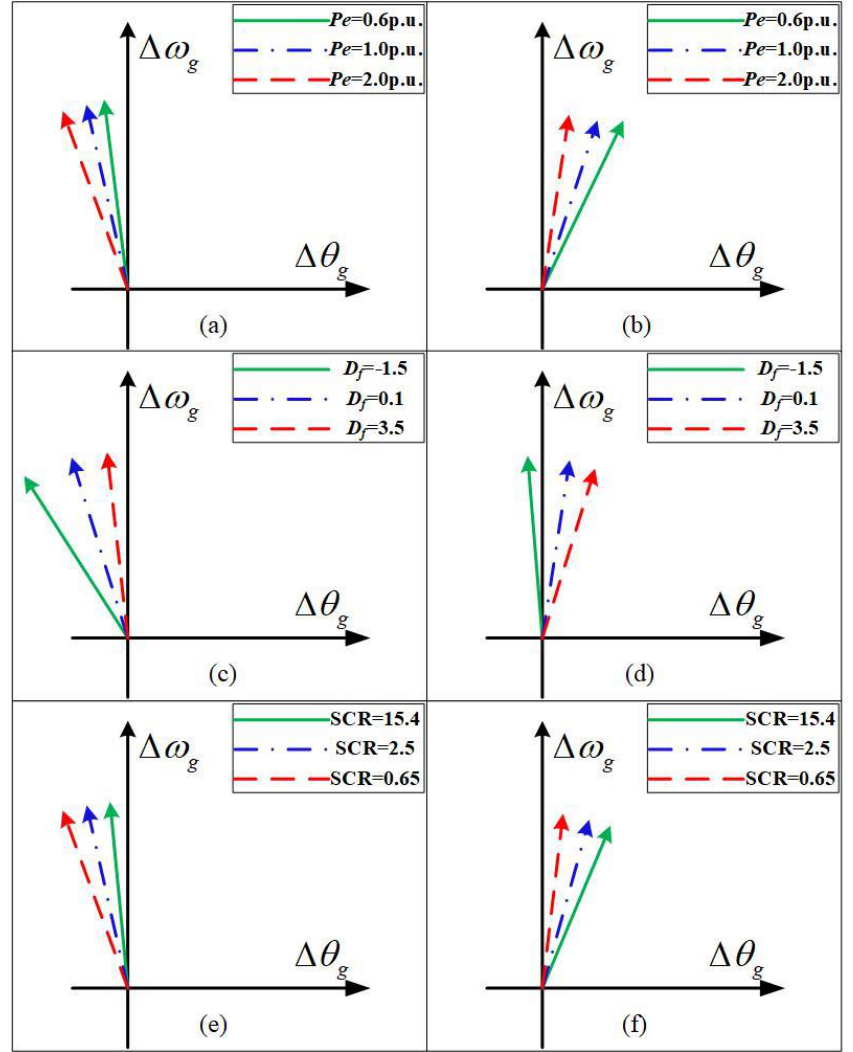
Figure 15. Phasor diagrams of ∆ T e 1 ( a , c , e ) and ∆ T e ( b , d , f ) with varying operating points, values of D f in auxiliary correction loop and grid strengths.